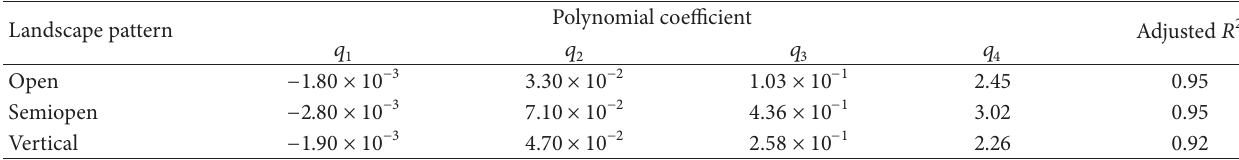
Table 5: Polynomial coefficients 𝑞 𝑖 and fitting degree 𝑅 2 of the curves in the simulator test.